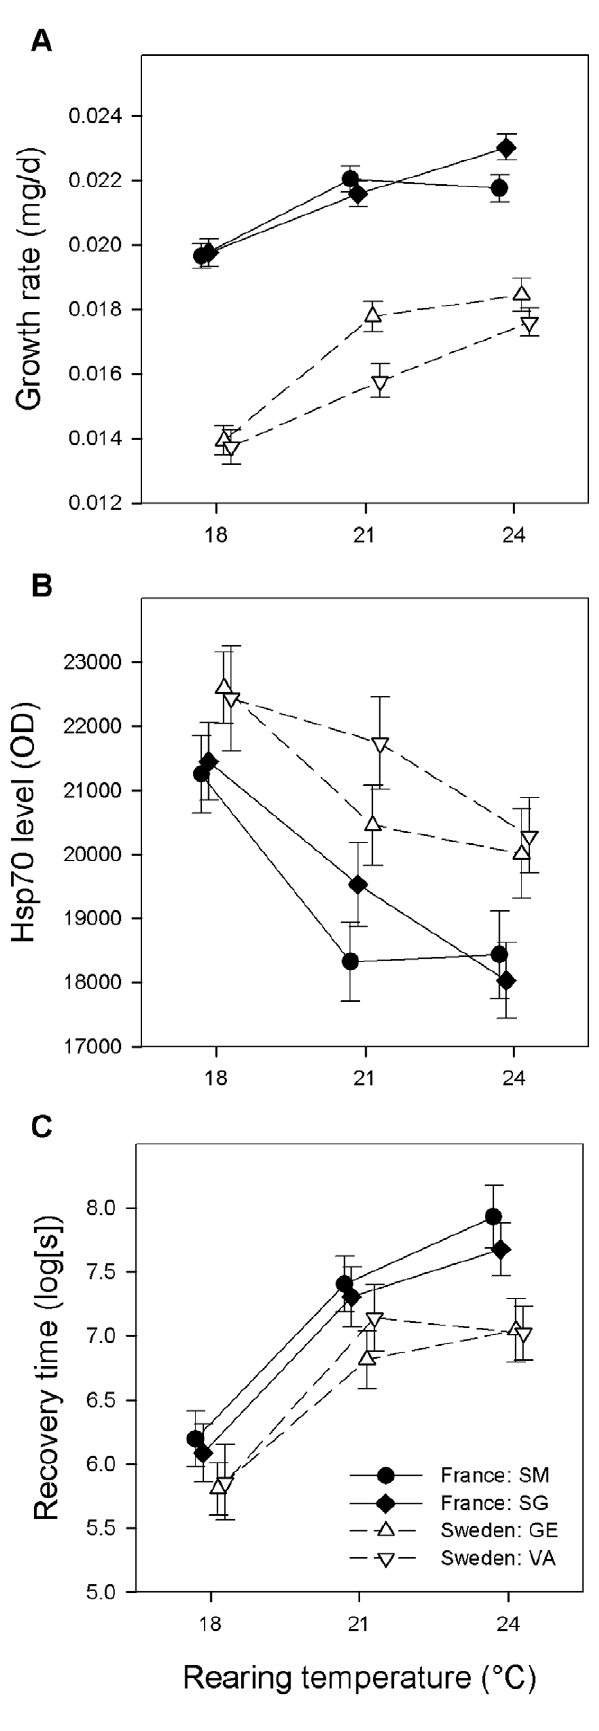
Figure 1. Differences in growth rate, Hsp70 level and chill coma recovery time between latitudes across temperatures. Mean ( 6 1 SE) larval growth rate (A), and Hsp70 level (B) and chill coma recovery time (C) in the adult stage of Ischnura elegans from two northern and two southern populations at three rearing temperatures. Means are slightly offset to aid visualization. Hsp70 levels and chill coma recovery times are quantified after a cold shock treatment (1.5 h exposure to 4 u C) given to the freshly emerged